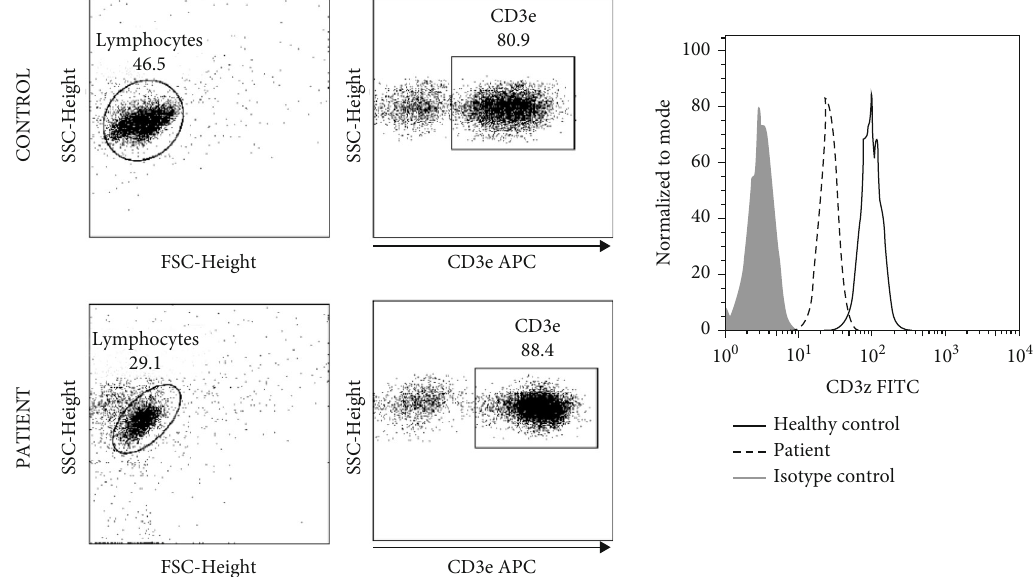
Figure 1: Representative DotPlots and histograms of the CD3z gating and MFI analysis. A two-gate strategy was employed, using forward scatter (FSC) versus side scatter (SSC) to characterize the previously isolated lymphocytes and CD3 ε to determine the T lymphocytes. CD3 ζ MFI were determined within the CD3 ε -positive